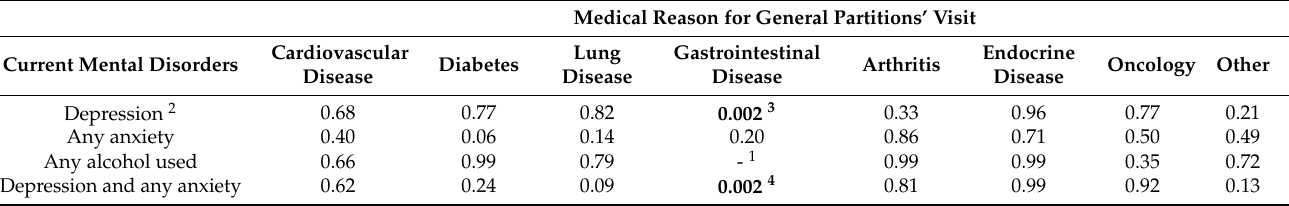
Table 3. Association of physical and mental conditions among persons with current suicidality in multivariate logistic regression